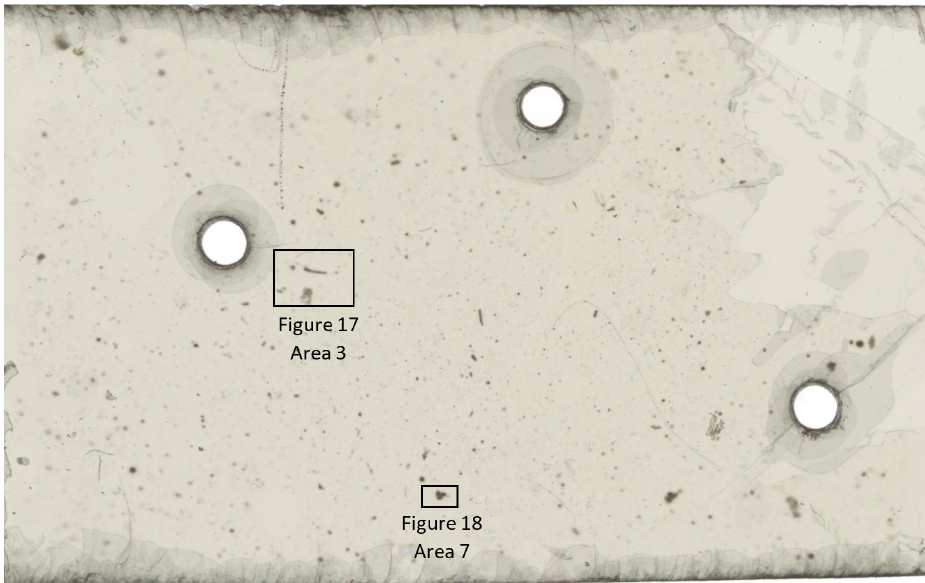
Figure 9. Fission-track mica image for GJAST-15-13 (total digestion uranium concentration of 7.18 mg/kg). Rectangles indicate zoomed-in areas with associated figure numbers. White circles are drill holes used to align the fission-tracked mica and the thin section. Length is 32 mm.